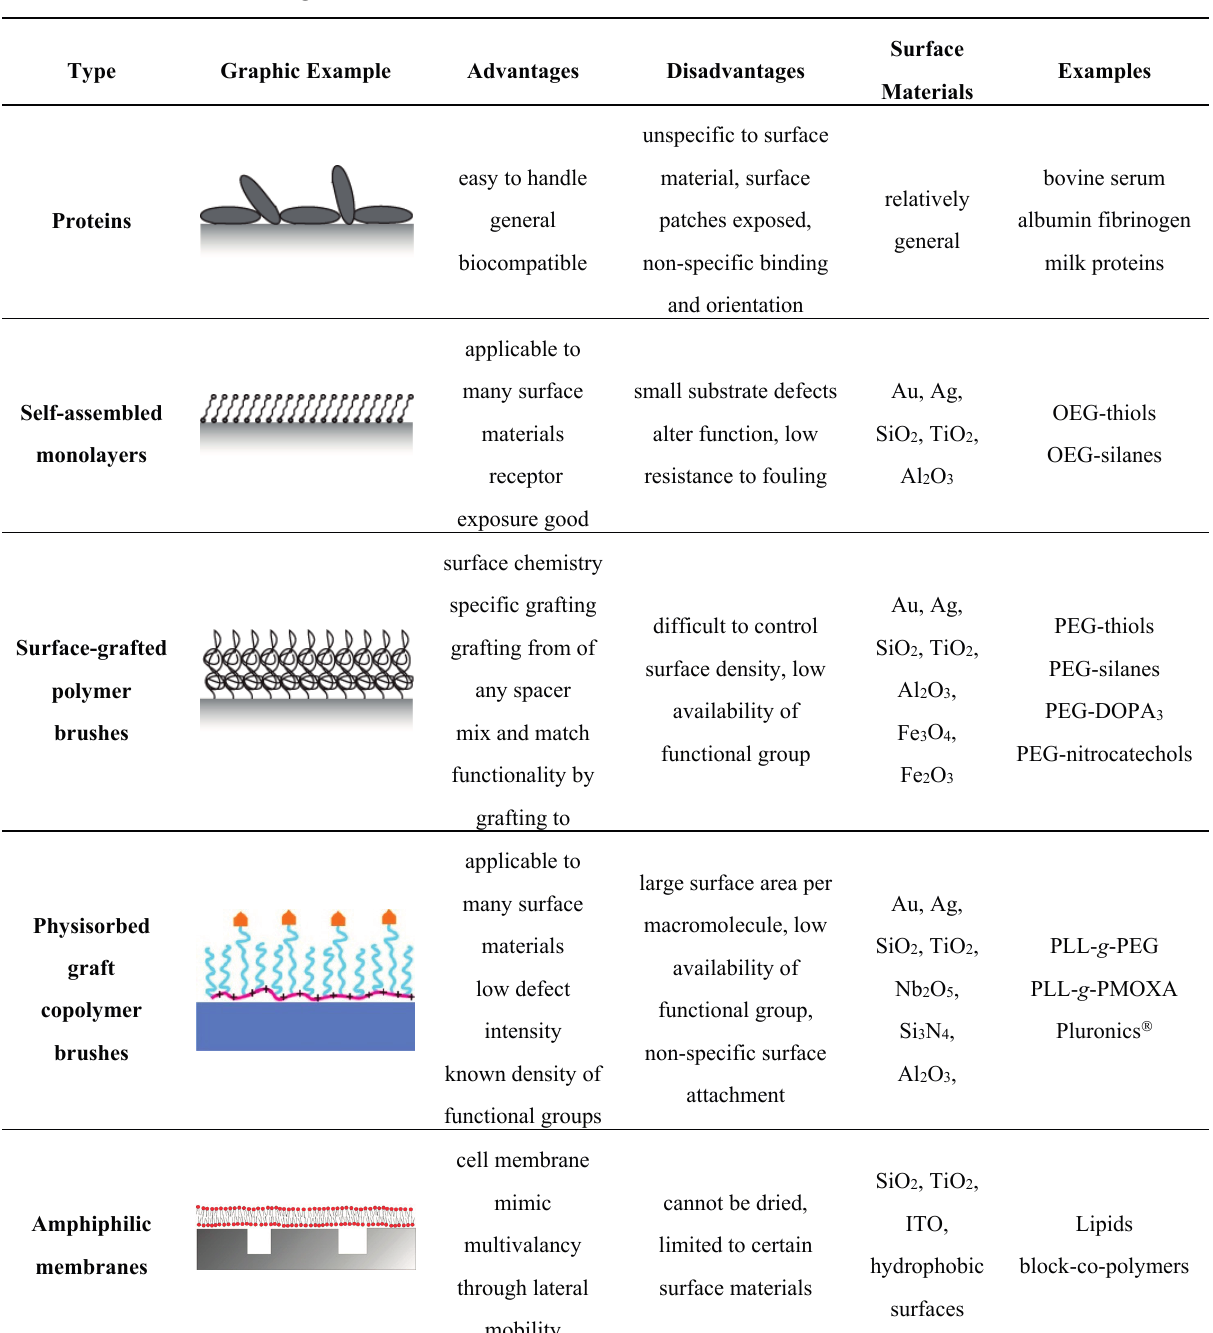
Table 2. Combinations of anchors and spacers that render substrates inert to non-specific biomolecular